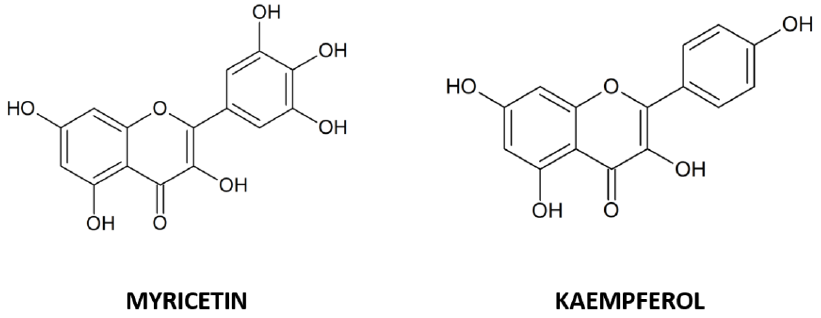
Figure 1. Chemical structures of the flavonols myricetin and kaempferol.